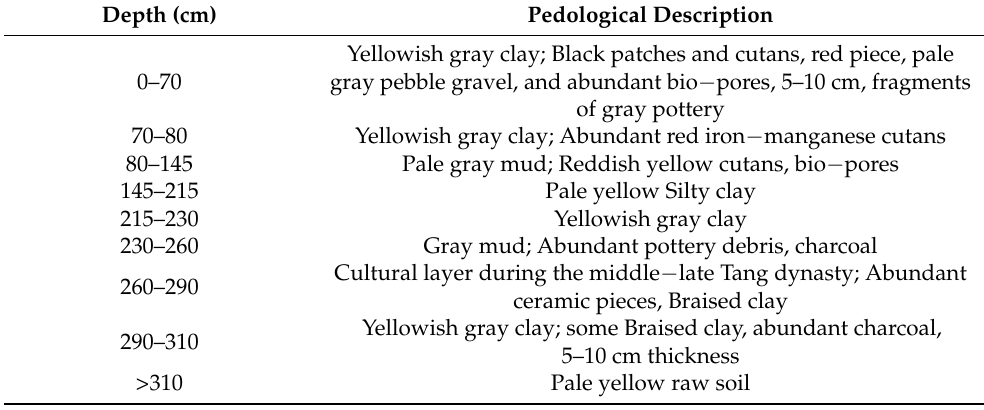
Table 1. Description of the SZP